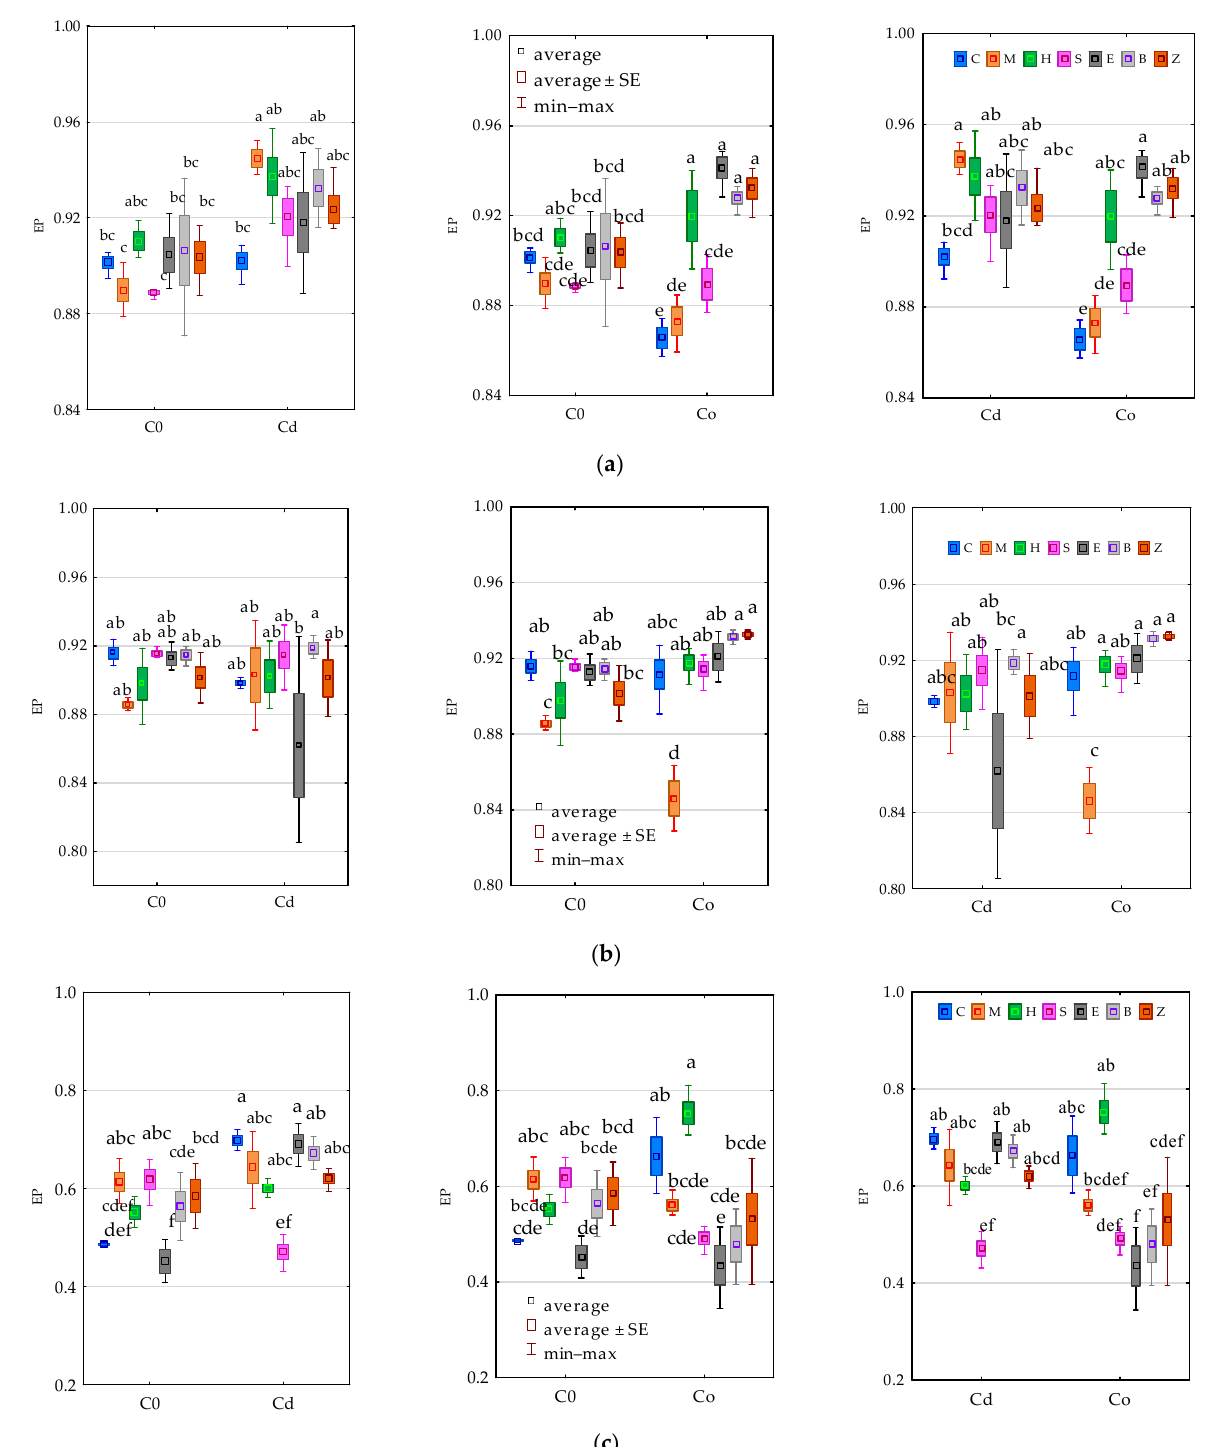
Figure 3. Effect of soil contamination with cadmium (Cd 2+ ) and cobalt (Co 2+ ) on the colony diversity index (EP) of ( a ) organotrophic bacteria (Org), ( b ) actinomycetes (Act) and ( c ) fungi (Fun). C0—